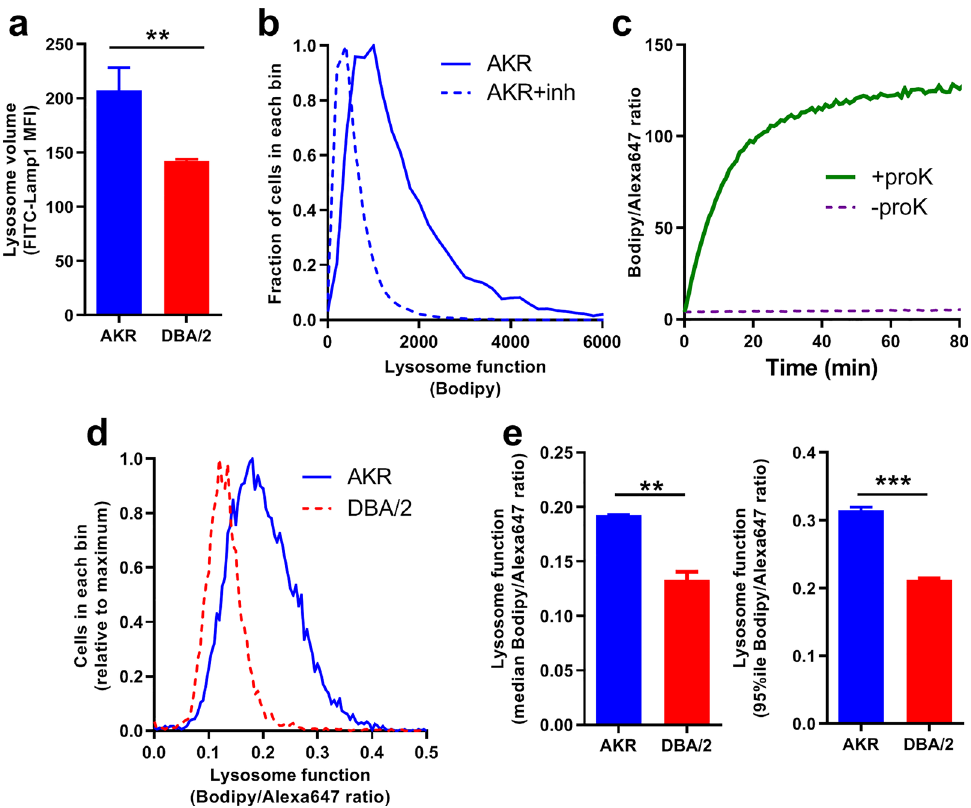
Figure 1. Decreased lysosome function in DBA/2J versus AKR/J macrophages. ( a ) Lysosome volume was assessed by incubating BMDM with 10 µg/mL FITC-labeled anti-Lamp1 antibody and examined by flow cytometry (median fluorescence intensity; n = 3 per strain, AKR blue bars; DBA/2 red bars). ( b ) Lysosome function in AKR/J BMDM was assessed by incubating cells with DQ-ovalbumin for 30 min and examined by flow cytometry (solid line). Lysosome inhibition with 3 h pretreatment of 10 µg/mL E64d plus 10 µg/mL pepstatin A led a leftward shift (dashed line) indicating decreased lysosome function. ( c ) Validation of lysosome function indicator in vitro showed proteinase K increased Bodipy/Alexa647 fluorescence ratio. ( d ) Lysosome function assay in AKR (solid blue line) and DBA/2 (dashed red line) BMDM was assessed by incubating cells with 2 µg/mL lysosome function indicator for 1 h and examined by flow cytometry. ( e ) Analysis of lysosome function in AKR (blue bars) and DBA/2 (red bars) BMDM using median (left panel) or the 95th percentile (right panel) fluorescence intensity ratio (duplicate assay) (**, p < 0.01; ***, p < 0.001 by two-tailed t-test). Graphs prepared using GraphPad Prism software v9.0.0 (www. graph pad.